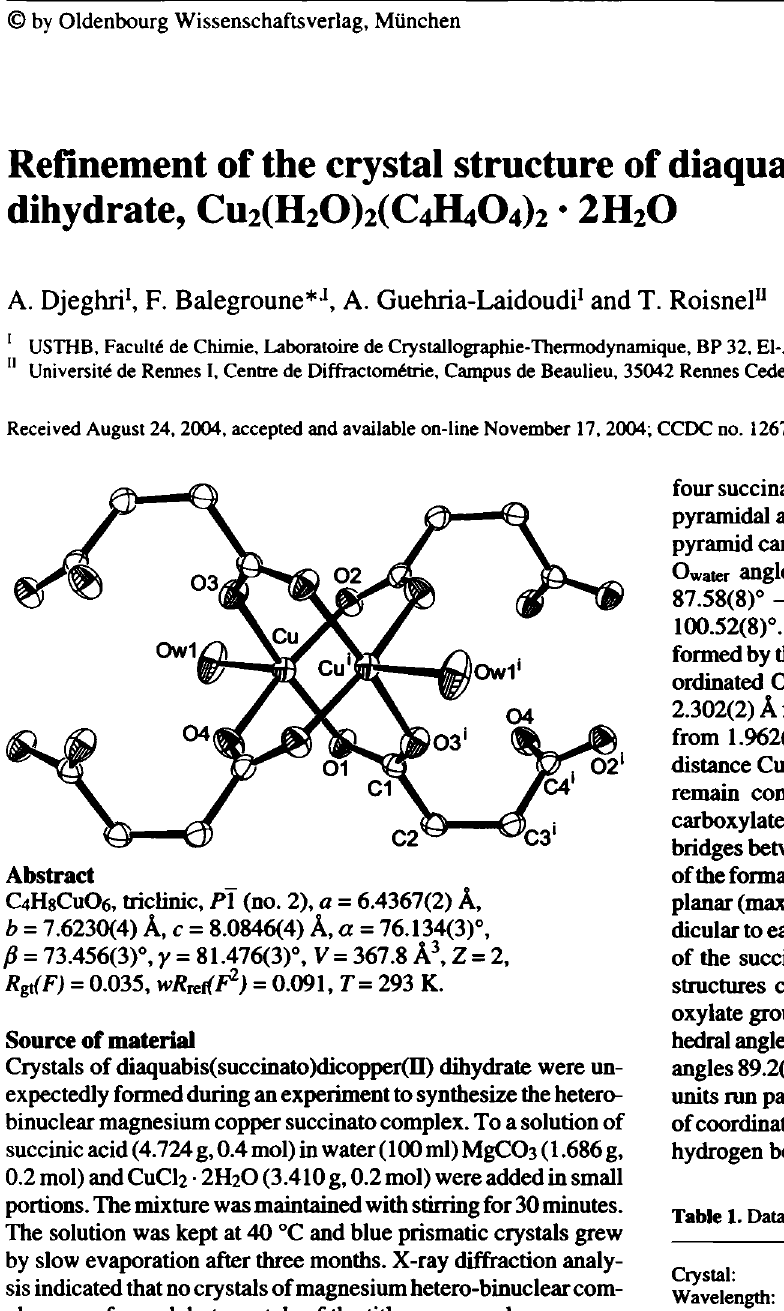
Table 2. Atomic coordinates and displacement parameters (in Â 2